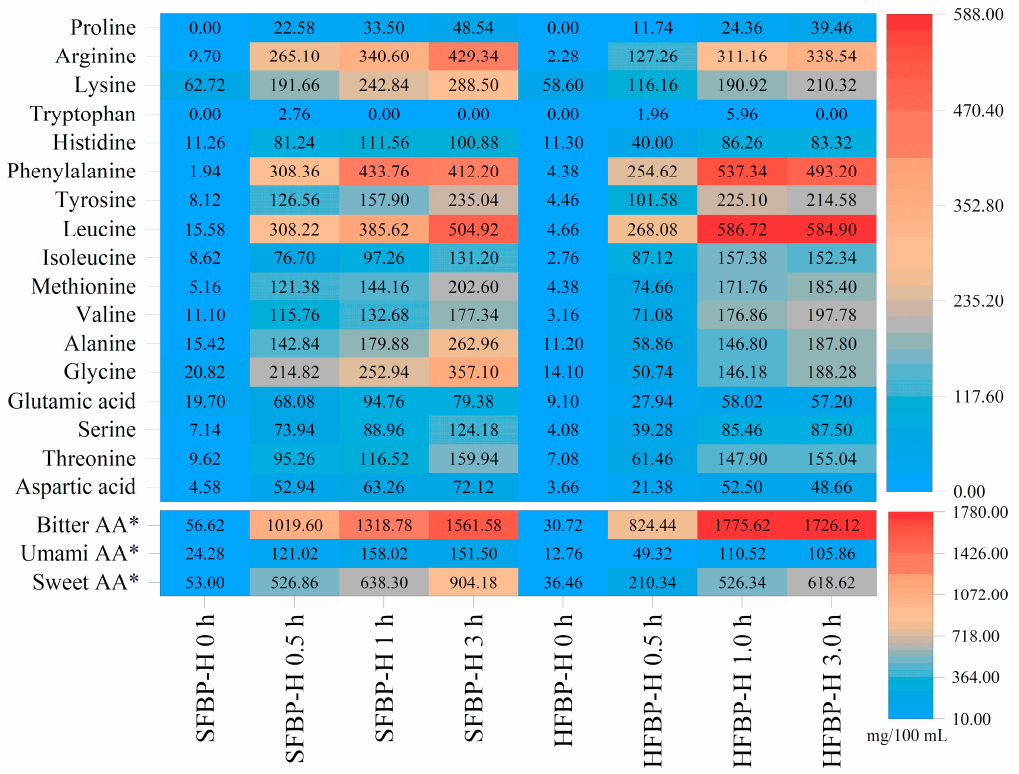
Figure 4. Heatmap of FAAs’ composition (mg/100 mL) and major taste components of FBP hydrolysates. SFBP: fish bone protein prepared through steam explosion-assisted extraction; HFBP: fish bone protein prepared through hot-pressure extraction; SFBP-H: SFBP hydrolysates; HFBP-H: HFBP hydrolysates. * Bitter AA: calculated from the sum of valine, isoleucine, leucine, phenylalanine, histidine, tryptophan and tyrosine; Sweet AA: calculated from the sum of threonine, serine, glycine and alanine; Umami AA: calculated from the sum of aspartic acid and glutamic acid.